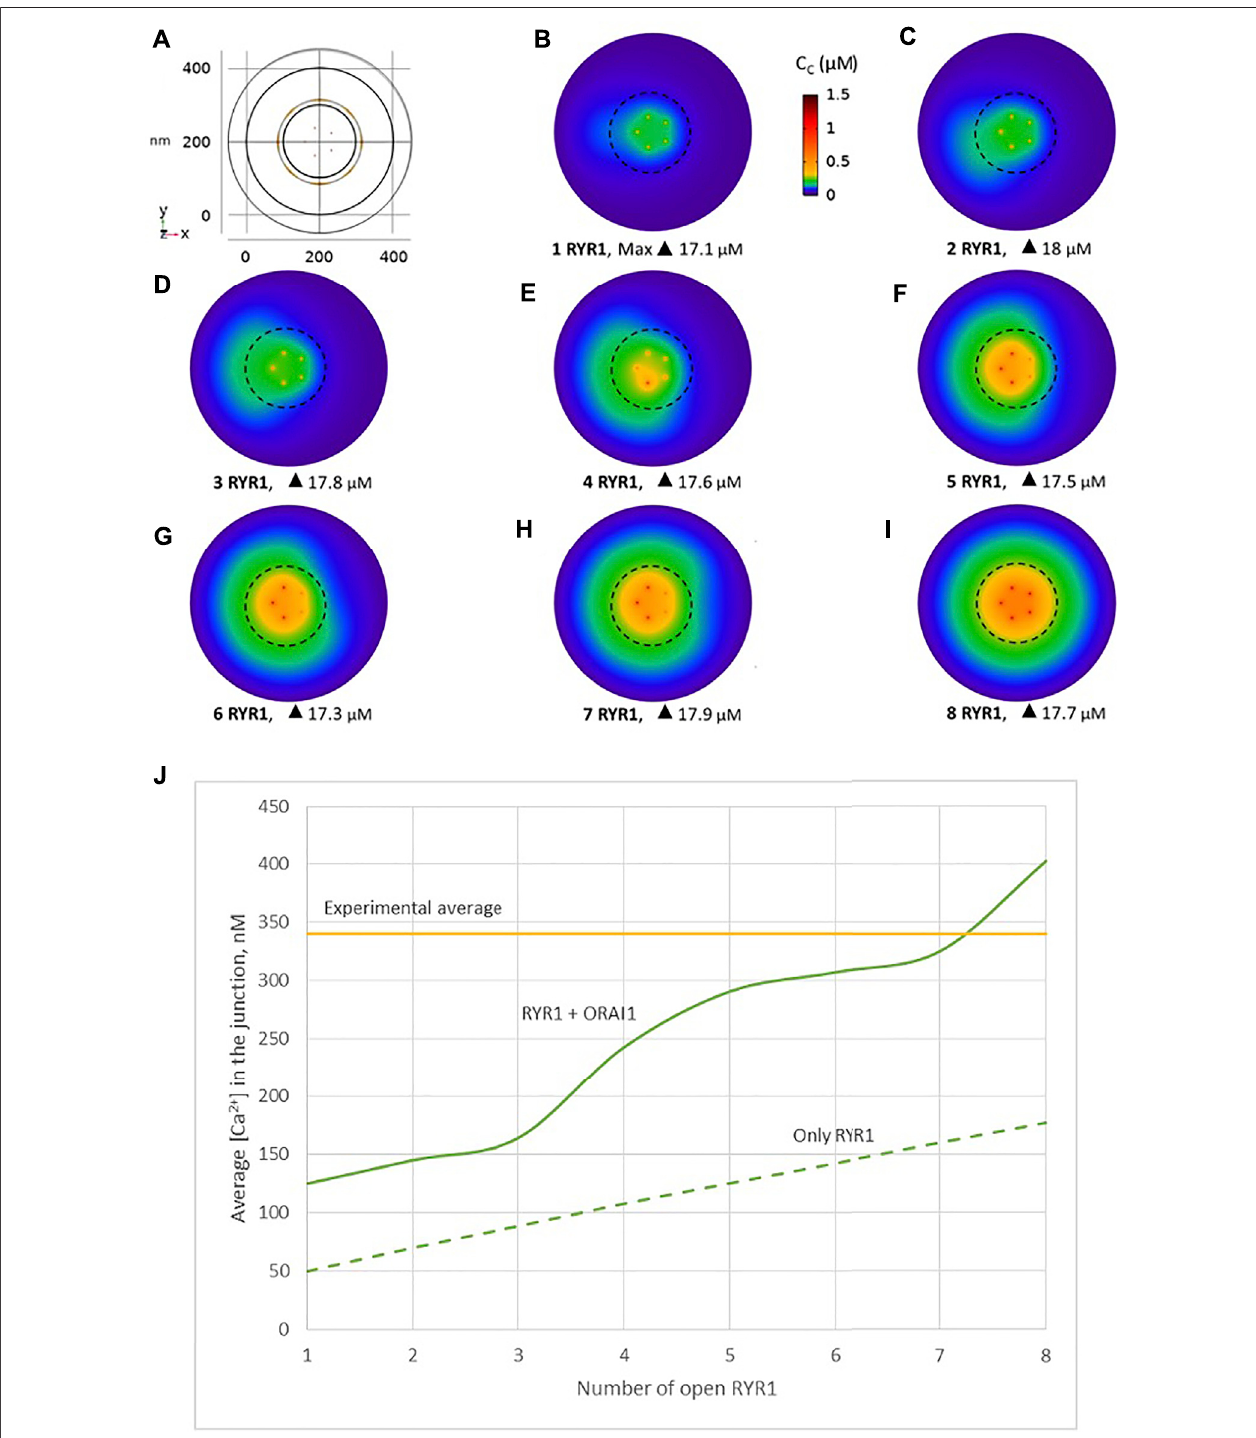
FIGURE5| SimulatedCa 2+ microdomainsresultingfromtheopeningoftheRYR1adjacenttothejunctions,whichinturninducestheopeningofORAI1channelsin the junctions as a result of local depletion of ER Ca 2+ (A) Upper view of the arrangement of the ORAI1 channels on the PM of the junction (red dots) and of the adjacent RYR1 (yellow lines) using COMSOL (B – I) Steady-state Ca 2+ pro fi les in the junction when opening 1 (B) to 8 (I) RYR1 simultaneously. Shown are the pro fi les 22 ms after opening of the RYR1. Upon depletion of local Ca 2+ in the ER, which is quasi-instantaneous, ORAI1 channels open to an extent that depends on this local concentration, as de fi ned by the function f 2/1 (see Supplementary Information ). ORAI1 opening is assumed to occur immediately after depletion because ORAI1- STIM1/2 aggregates are pre-formed (Weiss and Diercks, unpublished results). (J) Evolution of the amplitude of the simulated Ca 2+ microdomains with the number of